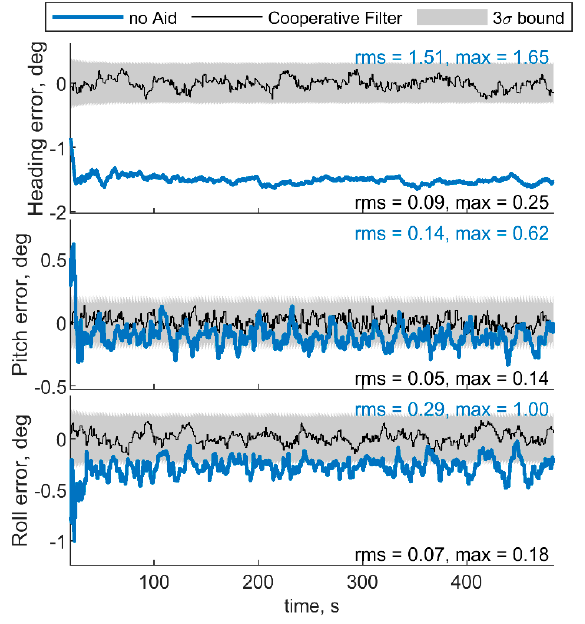
Figure 10. Errors on angle estimated by the cooperative filter in blue and by the same filter without using cooperation. Chief trajectory is reported in Figure 3. Two deputies, r = 40 m, μ = 60°, Δχ = 70°.